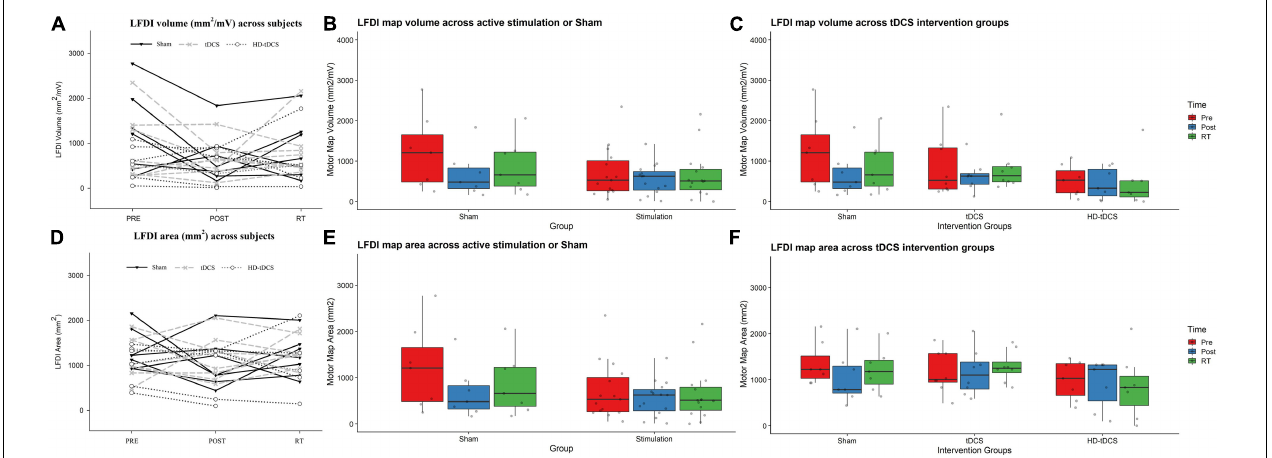
FIGURE 4 | LFDI map volume and area across robotic TMS motor mapping sessions. (A) LFDI map volume (mm 2 /mV) of each participant across mapping sessions. (B) LFDI map volume (mm 2 /mV) in active stimulation groups (tDCS and HD-tDCS) and Sham. (C) LFDI map volume (mm 2 /mV) in intervention groups (tDCS, HD-tDCS and Sham). (D) LFDI map area (mm 2 ) of each participant across motor mapping sessions. (E) LFDI map area (mm 2 ) in active stimulation groups (tDCS and HD-tDCS) and Sham. (F) LFDI map area (mm 2 ) in intervention groups (tDCS, HD-tDCS, and Sham). Map volume (mm 2 /mV) = Cumulative active map area × MEP amplitude (mV) at each responsive grid-point; Map area (mm 2 ) = Grid spacing (49mm 2 ) × number of responsive grid-points; Black line with triangle = Sham participants; Gray dashed line with X = tDCS participants; Gray dotted line with circle = HD-tDCS; LFDI = left-hand first dorsal interosseous muscle; Pre = baseline; Post = day 5; RT = six-weeks retention time. Box ends are interquartile range, the line is median, and the whiskers are